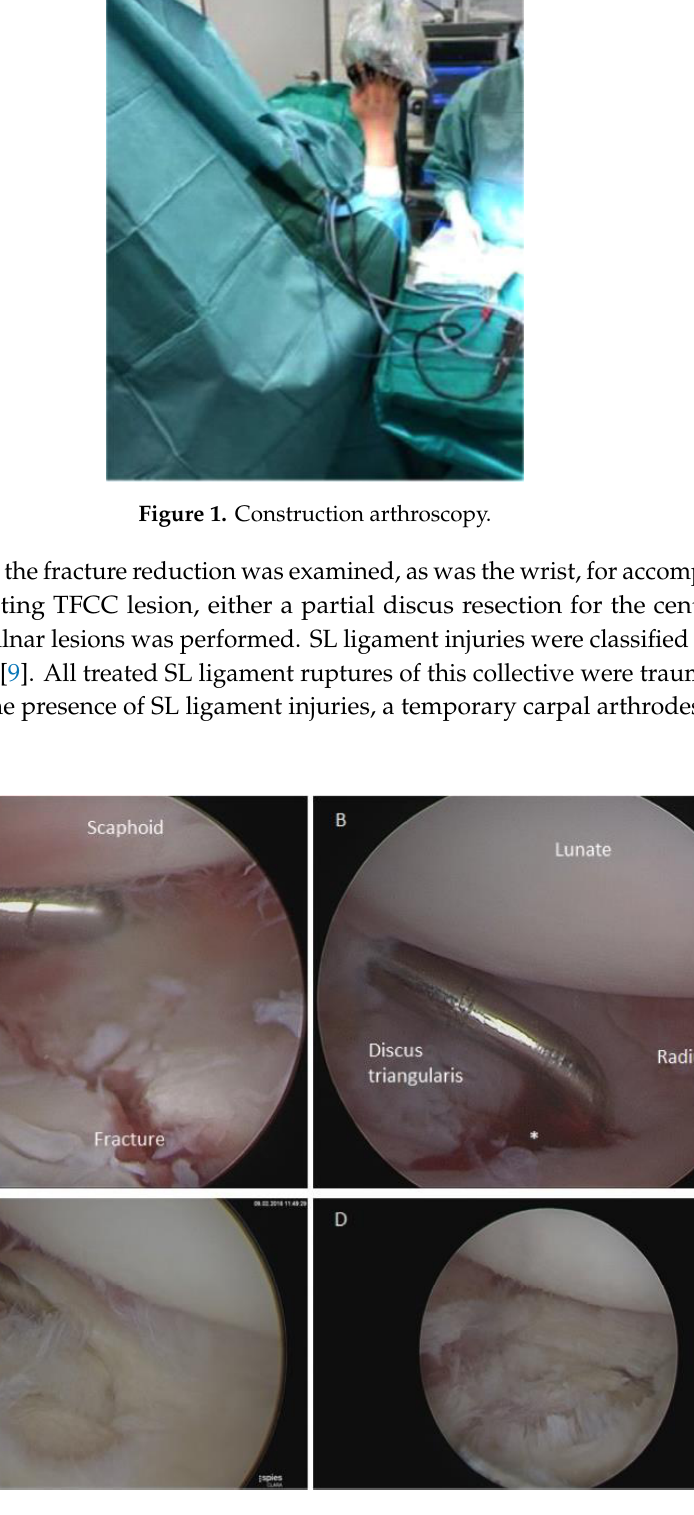
Figure 2. Arthroscopy. ( A ) Arthroscopically assisted distal radius fracture. The fracture has been